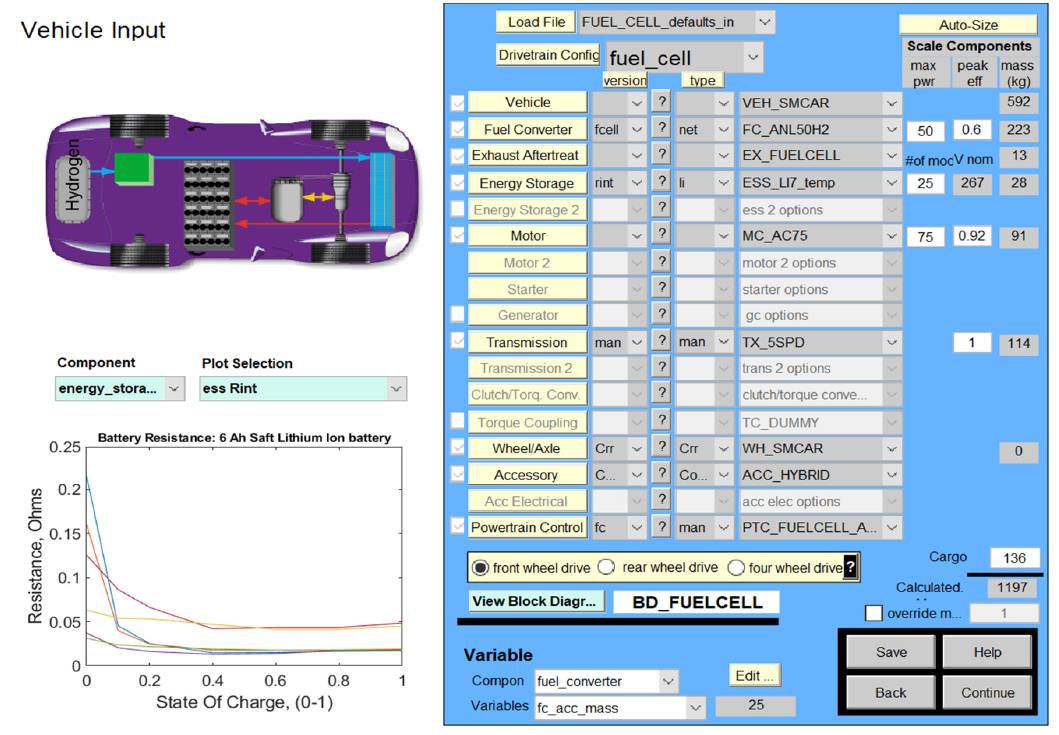
Figure 2. Vehicle input page setup.